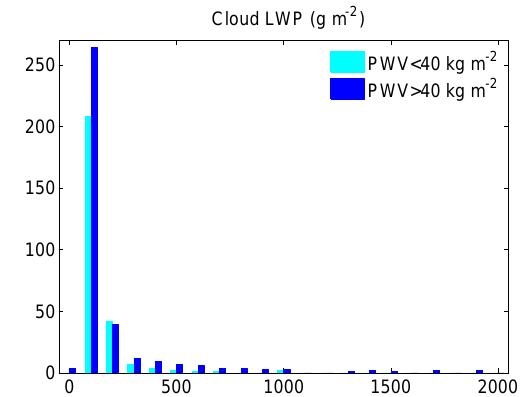
Figure A2. Frequency distribution of cloud LWP for wet (dark blue) and dry (cyan) cases. The clouds in the wet case exhibit more vari- ability in water content than do clouds observed under dry condi- tions (Table 3), possibly due to a lack of a well-defined boundary layer topped by a temperature inversion, which would act to limit cloud vertical development as in the dry